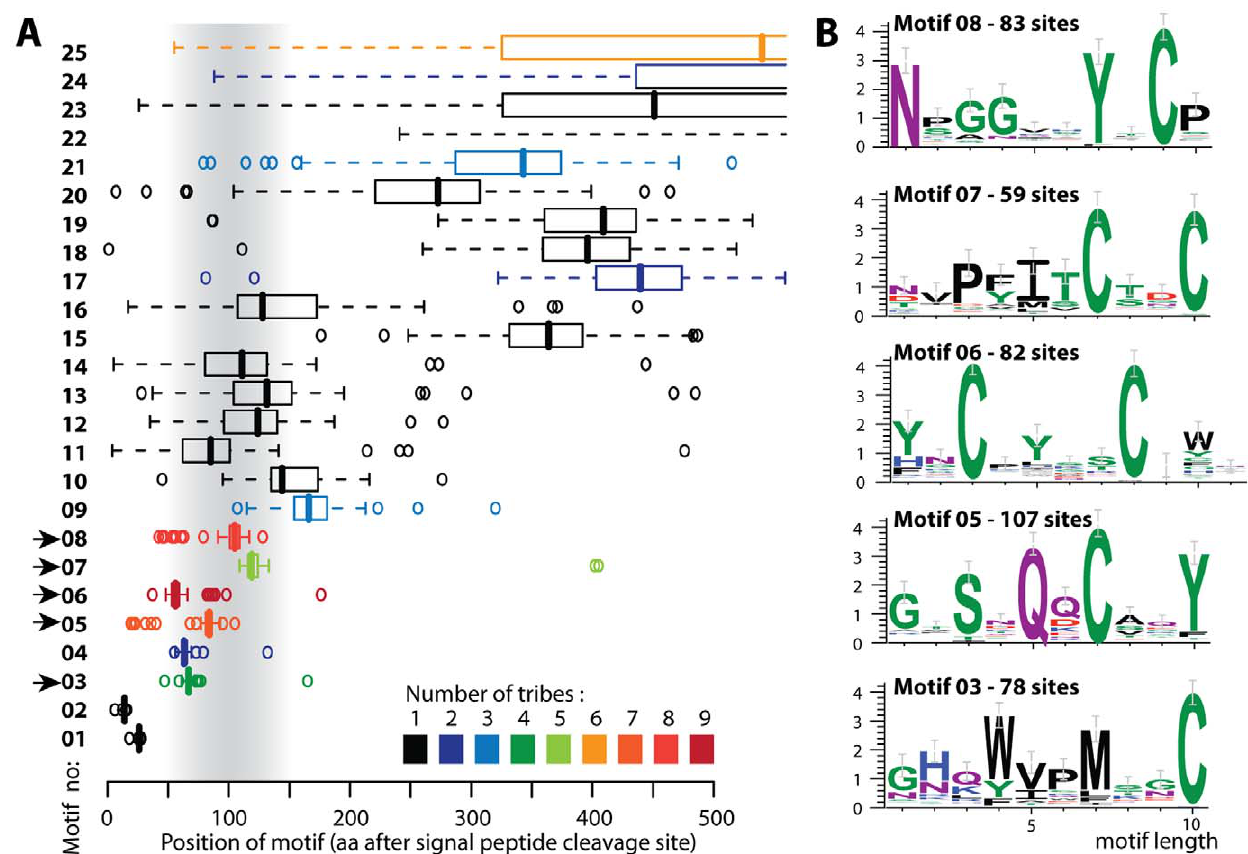
Figure 2. Denovo motif searches in the secretome of M.larici-populina and P.graminis f. sp. tritici reveal conserved cysteine rich motifs. (A) Amino acid position of 25 motifs in the secretome tribes of rust fungi reported by MEME. Arrows highlight positionally constrained motifs that are abundant in the secreted protein tribes. Position is given after the signal peptide cleavage site when applicable. Grey shading indicates the expected position for putative host-translocation motifs (amino acids 50 to 150). Box plots show median position (bar) first and third quartiles (box), first values outside 1.5 the interquartile range (IQR) (whiskers) and outliers (dots), coloured according to the number of tribes containing at least two proteins harbouring the motif. Motifs are classified by decreasing IQR from top to bottom. (B) Sequence logos of motifs with the highest positional constraint, distribution over the largest number of tribes and greatest number of individual proteins (sites) containing the motif.